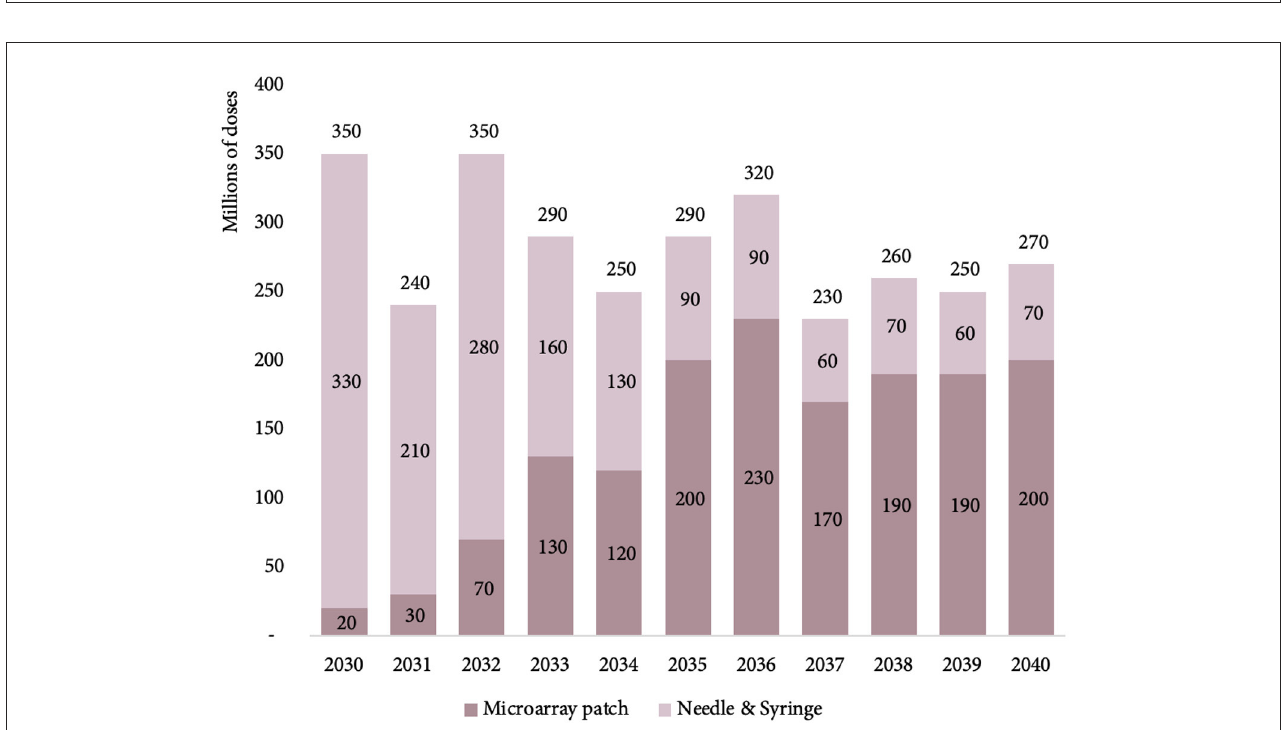
slums, remote rural, and security compromised populations) at